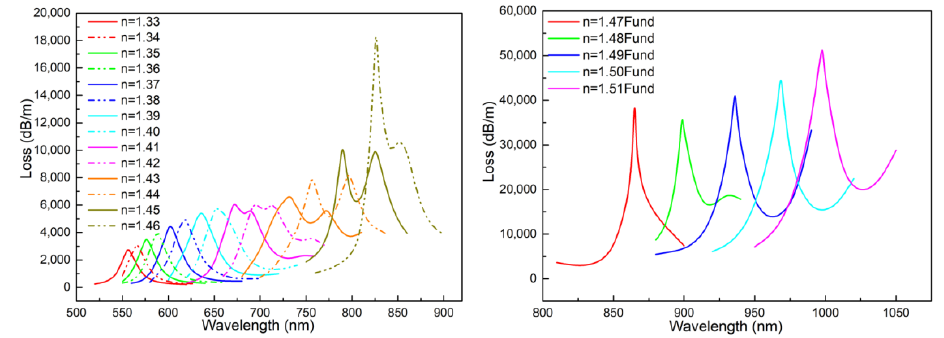
Figure 3. ( Left ): Loss when the refractory index (RI) of analyte ( n ) changes from 1.33 to 1.46; ( Right ): Loss when n varies from 1.47 to 1.51.